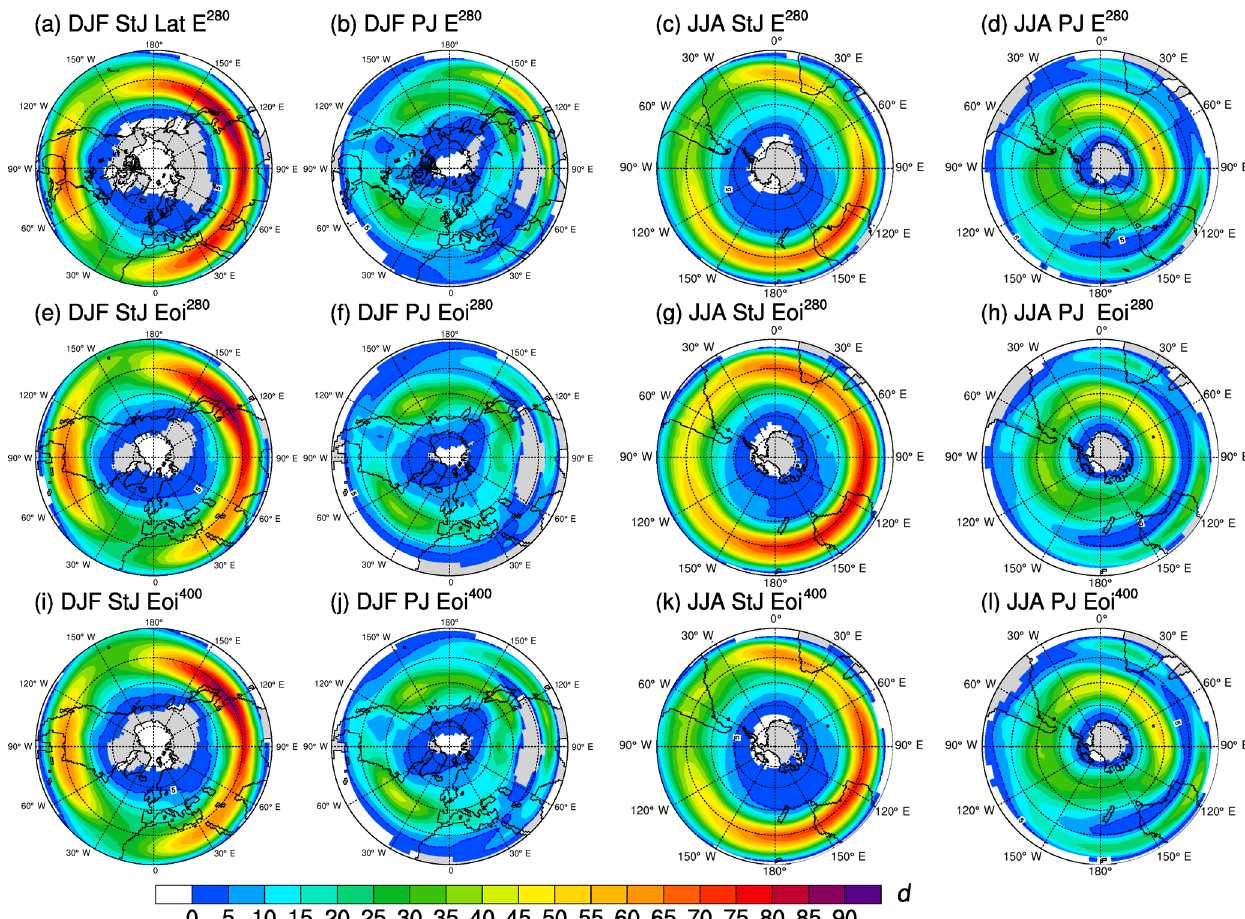
Figure 8. Seasonal (DJF and JJA) distribution of the StJ and PJ streams for (a–d) E 280 , (e–h) Eoi 280 and (i–l) Eoi 400 . Colour scale indicates the mean number of days within a season in which wind speed is > 30ms − 1 over 400–100hPa. Note that the wind-shear PJ classification identifies a jet downstream of the